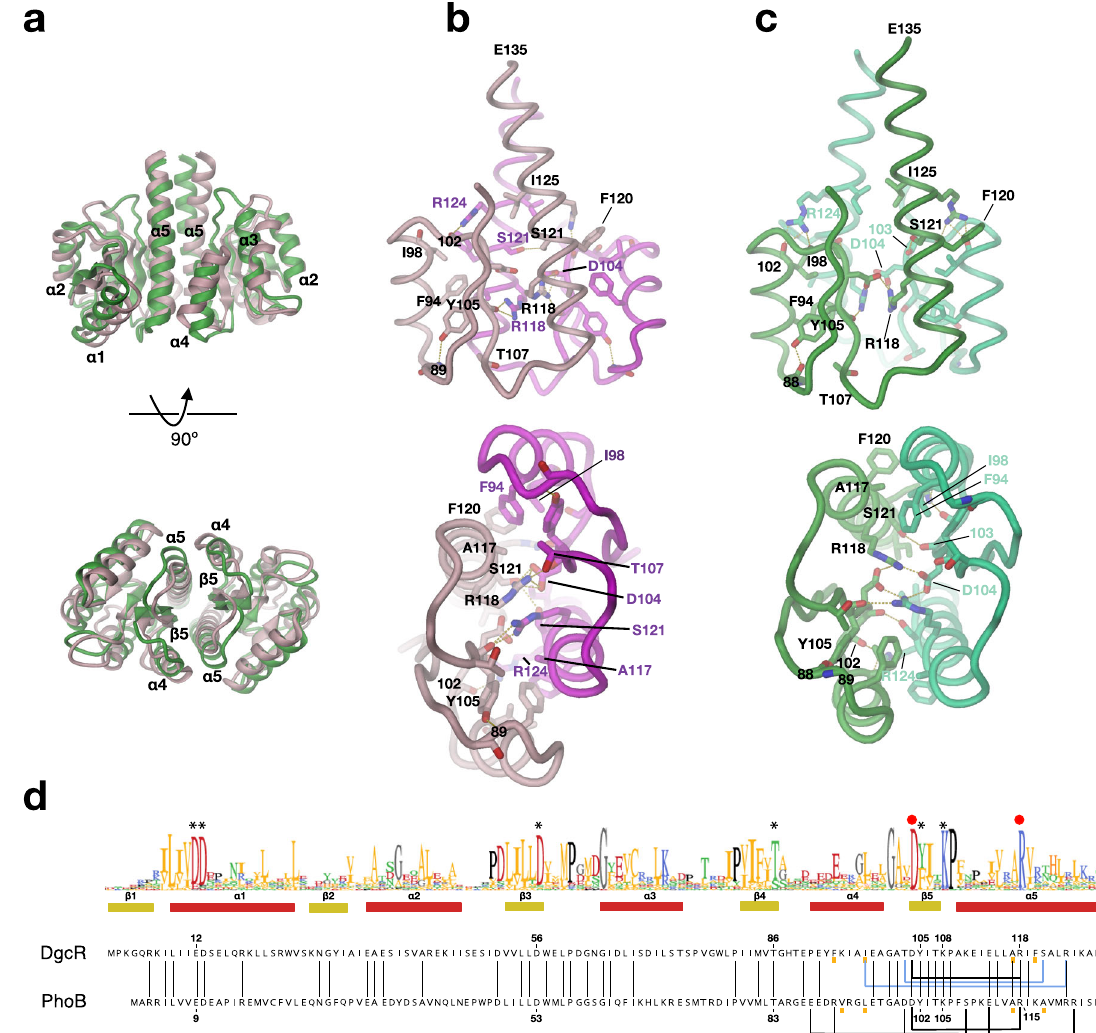
Fig. 4 Distinct packing of Rec domains upon BeF3- modi fi cation. a Superimposed dimers with native structure in pink and activated structure in green. b , c Rec dimer of DgcR ’ ( b ) and DgcR ’ * ( c ) with contacts between the protomers <3.2 A ̊ in yellow. d Sequence alignment of Rec domains of DgcR and PhoB with secondary structure elements of DgcR and sequence logo derived from DgcR group 1 homologues (see Fig. 10). Asterisks indicate conserved residues involved in Rec domain activation. Below the individual sequences, lines connect residues that participate in inter-domain contacts (side-chain – side-chain interactions in black, interactions involving the main-chain in blue). Red dots indicate D104 and R118 of the conserved intermolecular